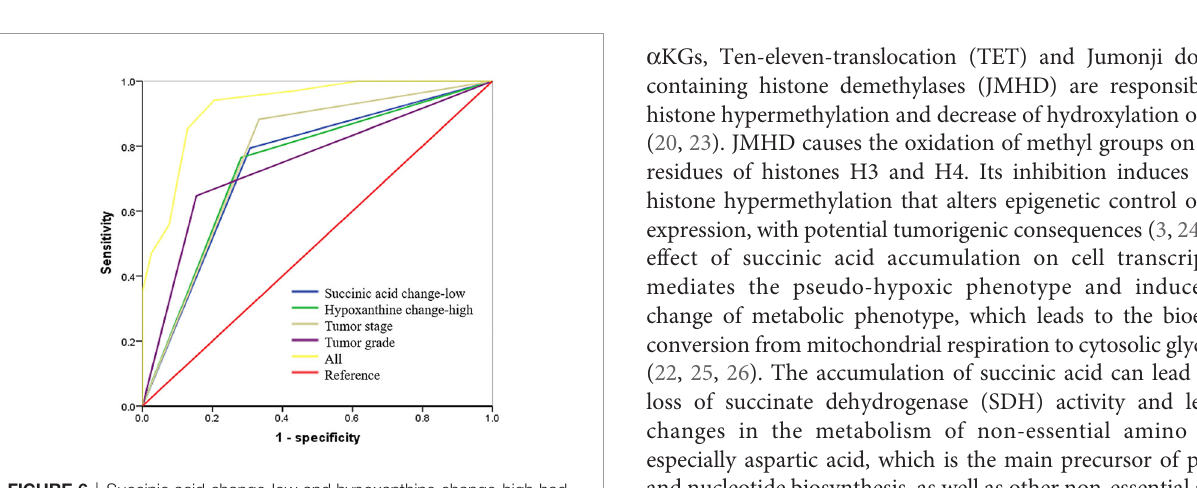
FIGURE 6 | Succinic acid change-low and hypoxanthine change-high had high predictive accuracy for 3-year recurrence-free survival (RFS). receiver operating characteristic (ROC) curves indicating the predictive accuracy, sensitivity, and speci fi city of each potential parameter. The area under the curve (AUC) values of succinic acid change-low, hypoxanthine change-high, tumor stage, and tumor grade (differentiation) were 0.743 (95% CI = 0.627 – 0.859), 0.794 (95% CI = 0.686 – 0.903), 0.775 (95% CI = 0.664 – 0.885), and 0.747 (95% CI = 0.629 – 0.864), respectively; but succinic acid change-low combined with hypoxanthine change-high and tumor grade provided the highest predictive accuracy (AUC = 0.900; 95% CI = 0.822 –